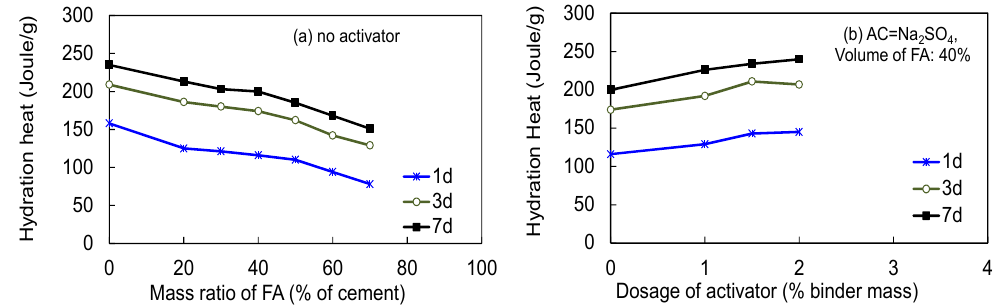
Figure 7. Effects of the content of FA and AC on the hydration heat of the FA-PC system. PC, Portland cement.